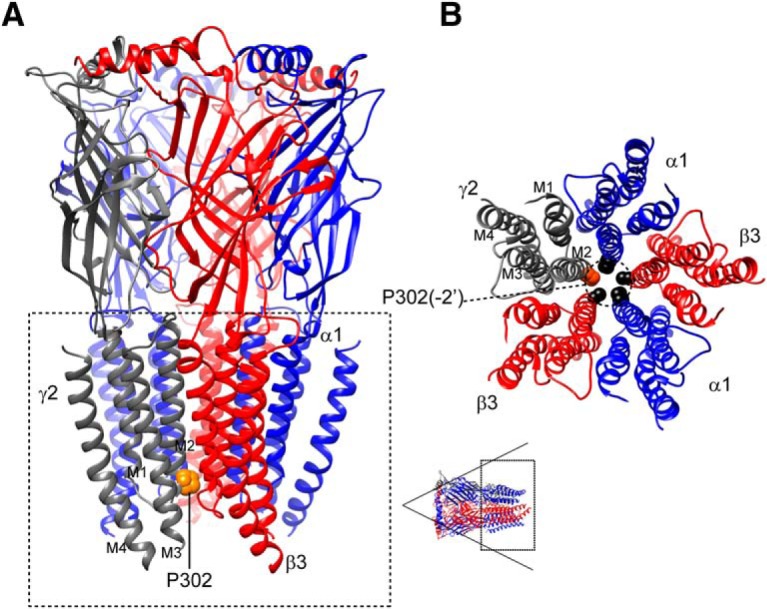
The de novo γ2(P302L) subunit mutation was an evolutionary conserved residue in the pore region of the GABAA receptor. A, A 3D structural model of the α1β3γ2 GABAA receptor was displayed with the β subunits in red, α subunits in blue, and the γ subunit in gray. The γ2(P302L) subunit mutation was mapped onto the structure and represented in orange. The dashed box represented the transmembrane domain of the receptor and transmembrane segments M1 to M4 were labeled in the γ2 subunit. B, The transmembrane domain of 3D structural model of the α1β3γ2 GABAA receptor, with residues at positions -2′ (dashed circle) in each transmembrane segment M2 was displayed as spheres and colored by subunit (γ2 in orange, and α1 and β3 in black). Subunits α1 (blue), β3 (red), and γ2 (gray) were labeled, and transmembrane segments M1 to M4 were labeled in the γ2 subunit. A 3D model was viewed from the extracellular side as shown in the lower left corner (dashed box); for clarity, the N-terminal extracellular domain was not shown.